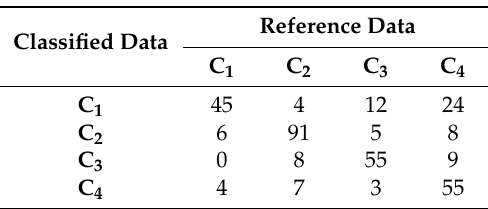
Table 4. Confusion matrix